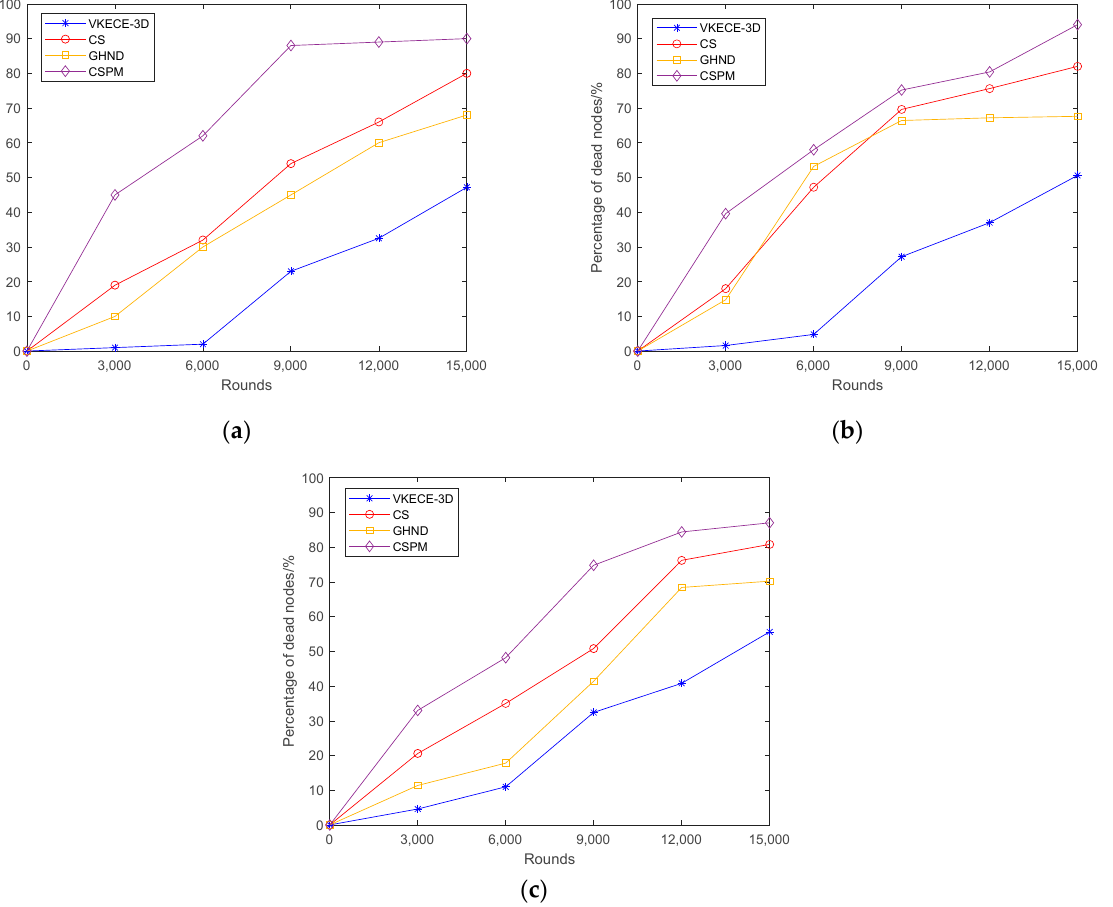
Figure 15. Node mortality of our proposed algorithm vs. comparison algorithms: ( a ) the small net-work, N = 100; ( b ) the medium-sized network, N = 250; ( c ) the large networks, N = 500.